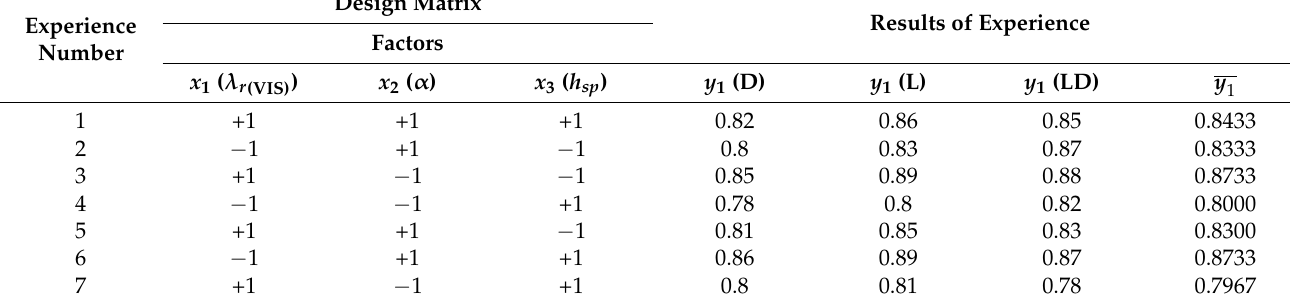
Table 3. Planning matrix for testing the efficiency of grading Scots pine seeds using a mobile optoelectronic separator in the visible wavelength